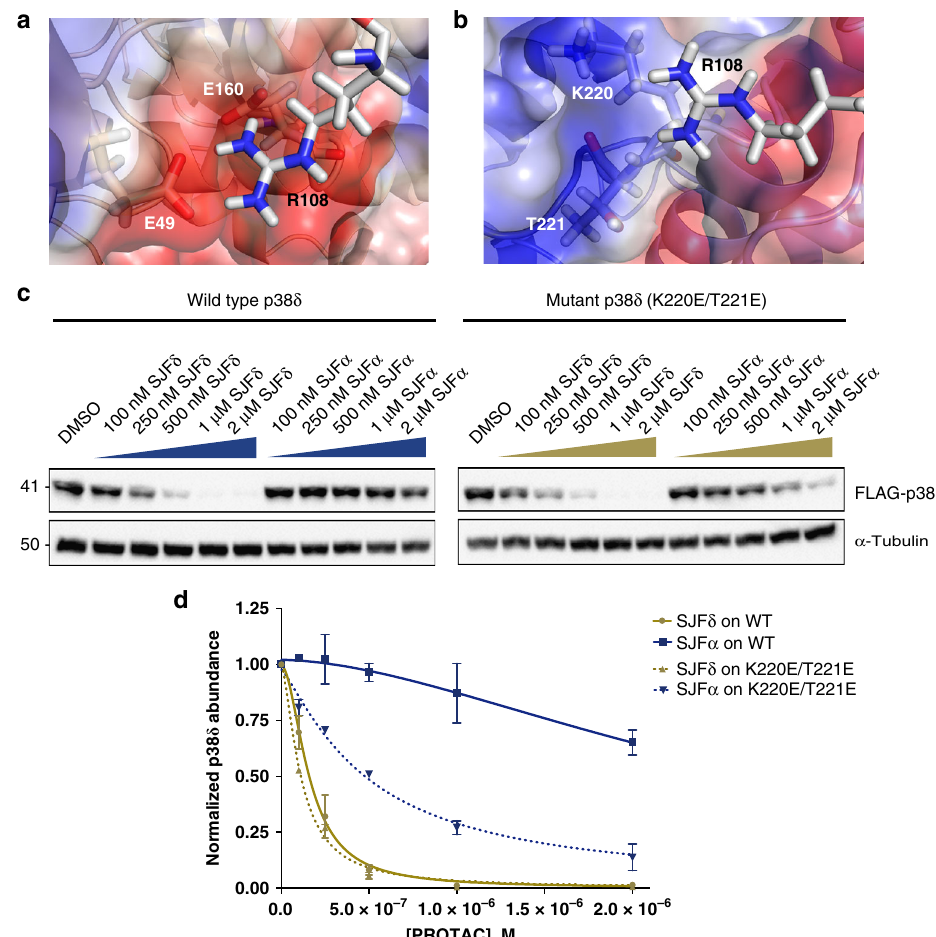
Fig. 6 Mutation of MD simulation-identi fi ed amino acids on p38 δ permits SJF α -dependent degradation by VHL. a MD simulation identi fi es amino acid residues of p38 δ and VHL that stabilize ternary complex in the presence of SJF δ . p38 δ is colored by electrostatic potential, from negative (red) to neutral (white) to positive (blue); interacting residue Arg108 of VHL is shown as sticks against the surface of p38 δ interacting with key residues Glu49, Glu160. b MD simulation identi fi es amino acids of p38 δ and VHL predicted to disfavor ternary complex in the presence of SJF α . p38 δ is colored by electrostatic potential, from negative (red) to neutral (white) to positive (blue); interacting residue Arg108 of VHL is shown as sticks against the surface of p38 δ interacting with charged and polar residues K220, T221, respectively. c SJF α potently degrades mutated (K220E/T221E) p38 δ , but not wild-type p38 δ expressed in HeLa cells. d Quantitation of wild-type or mutant (K220E/T221E) p38 δ levels in transfected HeLa cells treated with either SJF α or SJF δ . Levels of p38 δ are normalized to α -tubulin and values expressed relative to those from cells treated with DMSO (vehicle). Error bars display the s.d. of